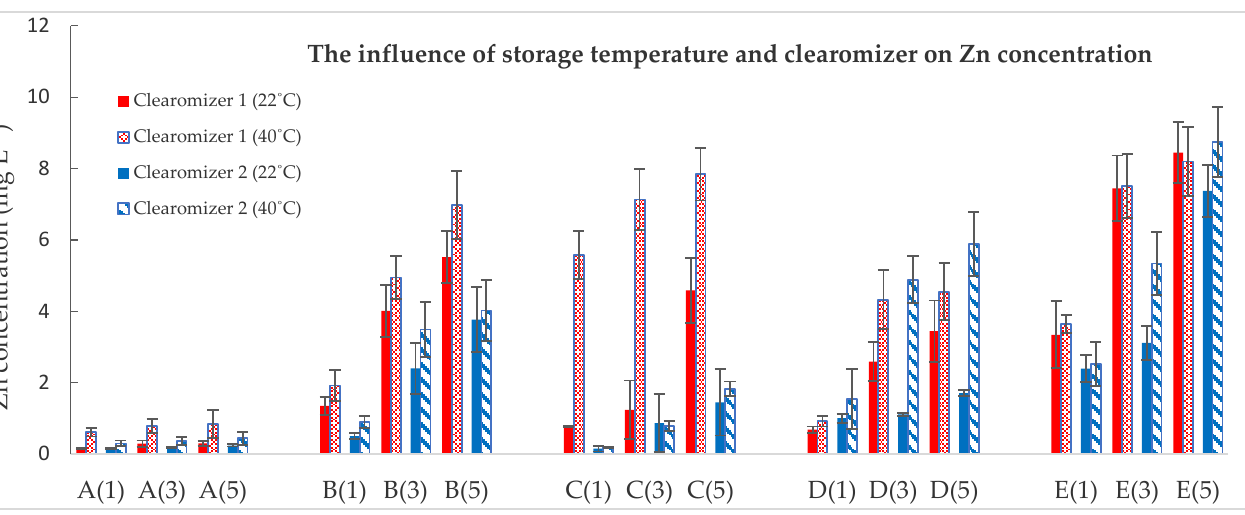
Figure 4. The influence of storage temperature and of the clearomizer on Zn concentration. Sample code: Sample number (number of storage days in the